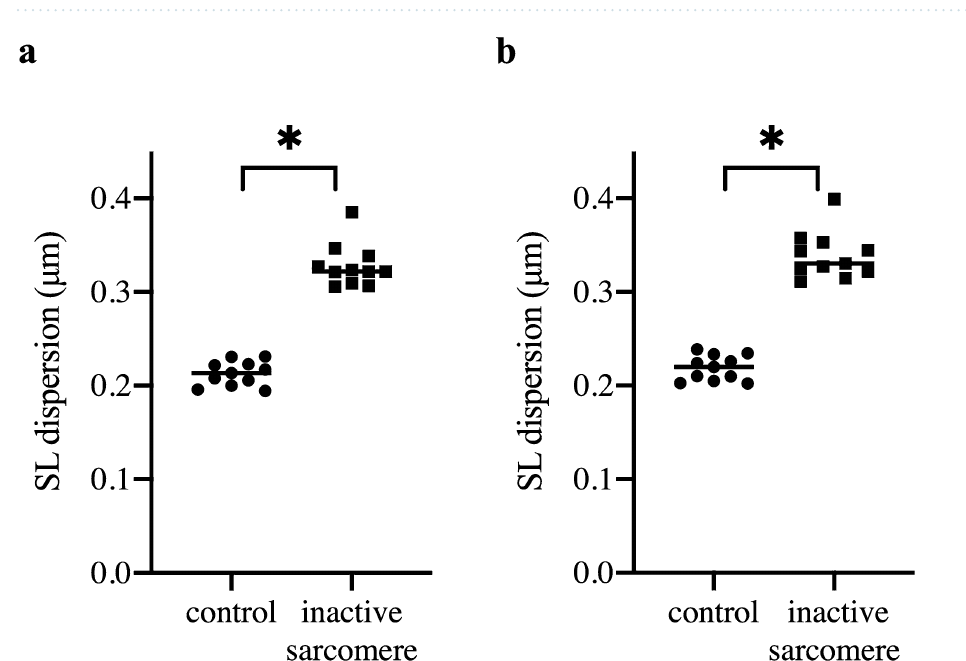
Figure 4. Sarcomere length (SL) dispersion of the myofibrils. The inactivation of a single sarcomere within the myofibril caused a significant increase in sarcomere length dispersion both before ( a ) and during ( b ) contraction ( P <